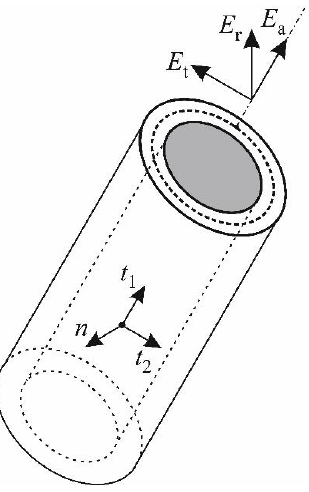
Figure 4. Soft-layer and cohesive contact geometries and reference systems. A contact interaction with “ normal-hard ” mechanical behaviour was defined on the outer surface of the soft-layer, which avoids the interpenetration of the nodes of the glu- lam member and the nodes of the soft-layer without the possibility of transferring tensile stresses in the direction normal to the surface. In defining the cohesive contact, the stiff- ness and resistance in the normal direction ( 𝐾 𝑛 = 0 N/mm 3 , 𝑓 𝑛 = 0 N/mm 2 ) were set to zero, in order to allow free separation of the two surfaces. With these positions and con- sidering a decoupled behaviour, the stiffness matrix of the interaction was hence reduced to: